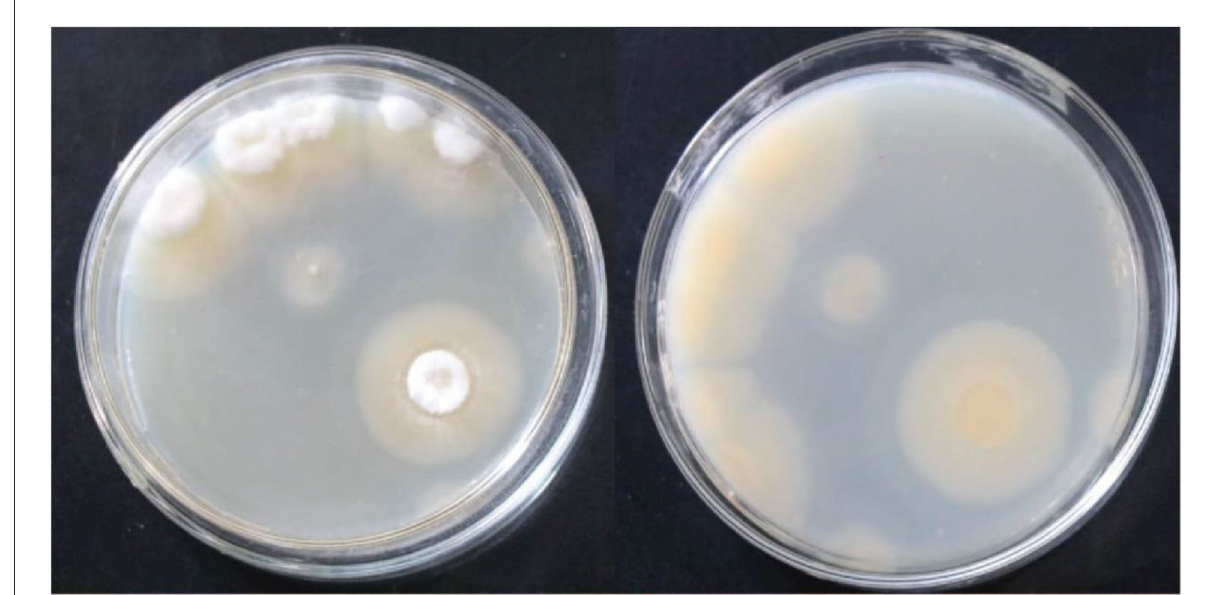
FIGURE1 Frontal and reverse colony morphology of the strain S1 after culturing on a PDA medium plate at 30 ◦ C for